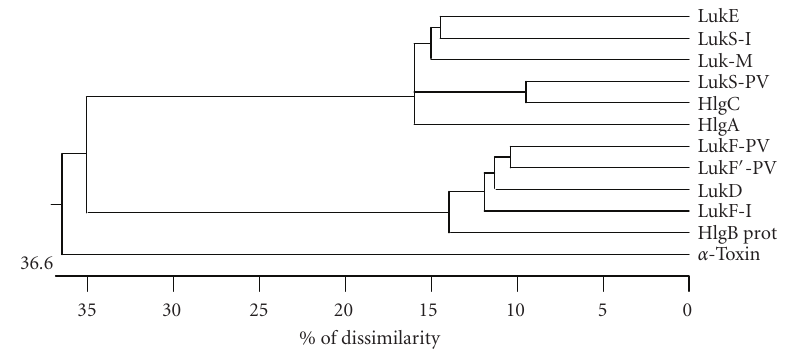
Figure 3: Philogenetic tree of peptidic homologies between the leucotoxins and α -toxin of S aureus . Unit = Euclidian distance (DNA Star, Ltd,